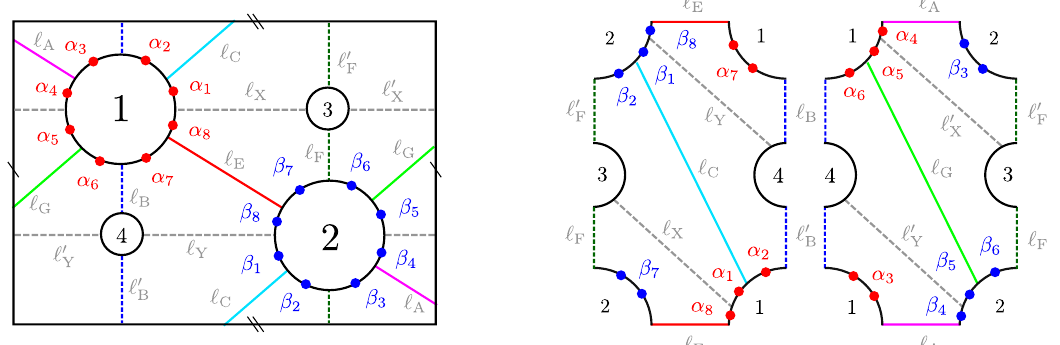
Figure 6 . We further detail the tessellation of the torus into eight hexagons. On the left, we draw the torus as a square; we insert two non-protected operators 1 ; 2, and tessellate the torus into four hexagons by cutting along the propagators (solid coloured lines) and along one of the torus’ cycles (coloured dotted lines). To regularise the construction we insert two identity operators labelled by 3 ; 4 along the coloured dotted lines. It is then natural to further cut the picture by drawing the gray dotted lines. In the right panel, we represent the eight hexagons arising from the